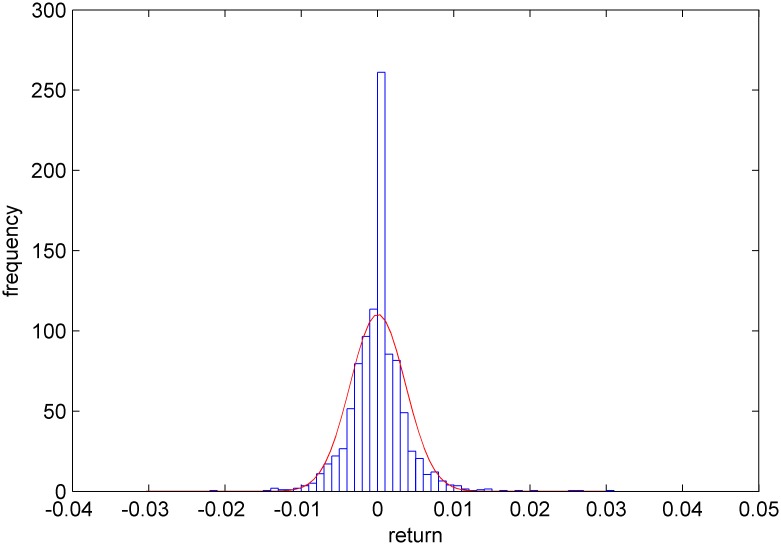
The yield distribution fitting diagram of Dongfeng Electronic Technology.